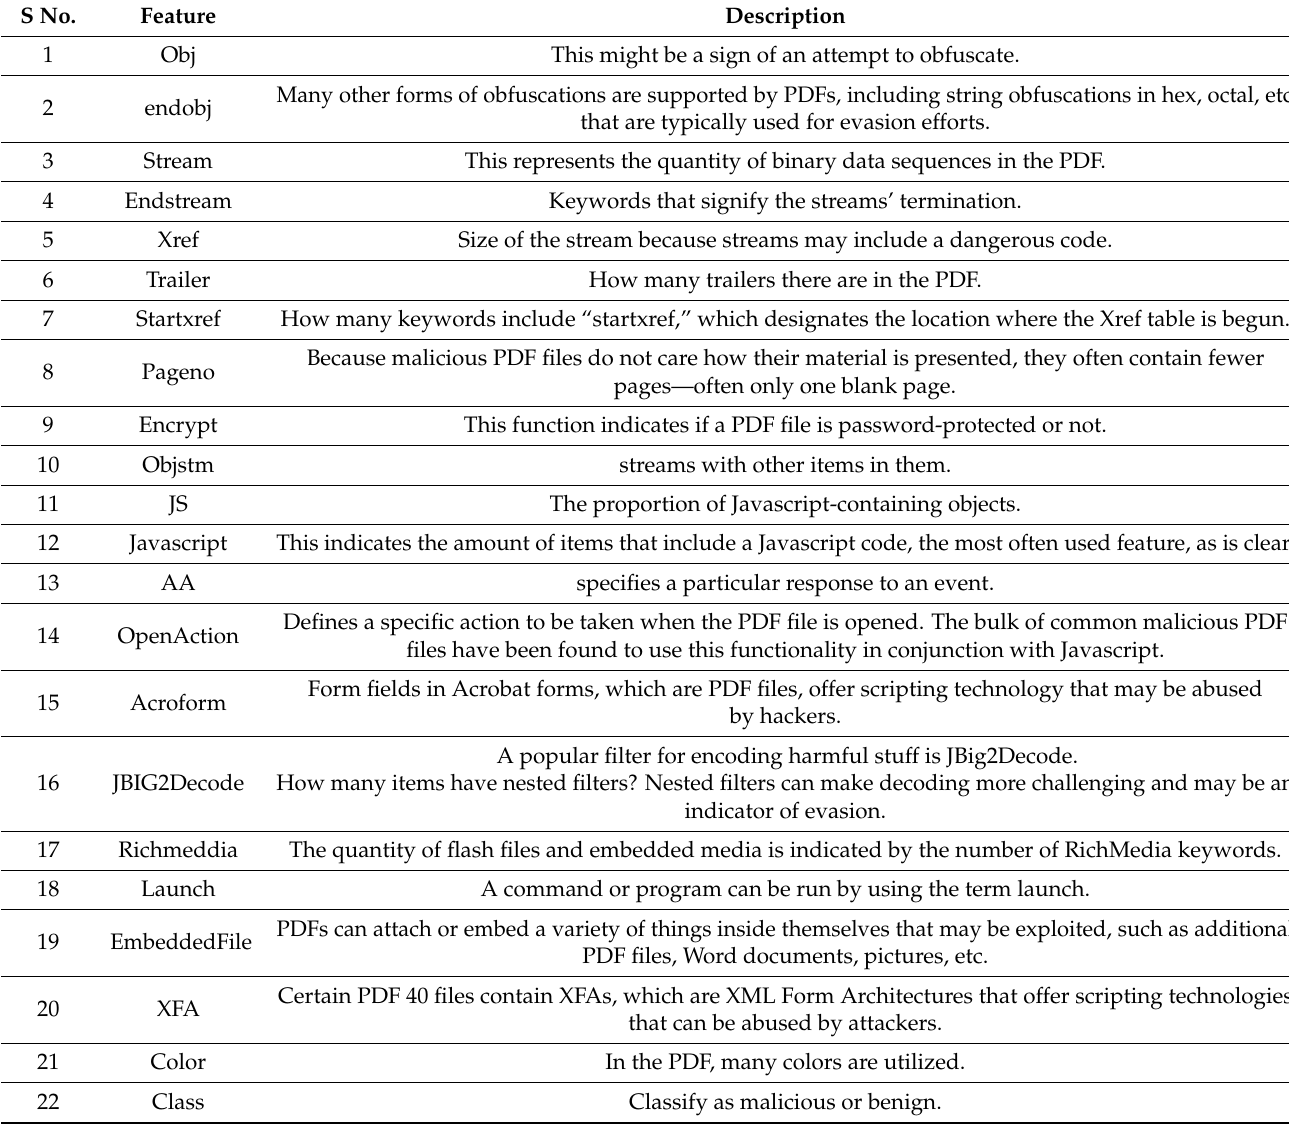
Table 1. Selected features with their